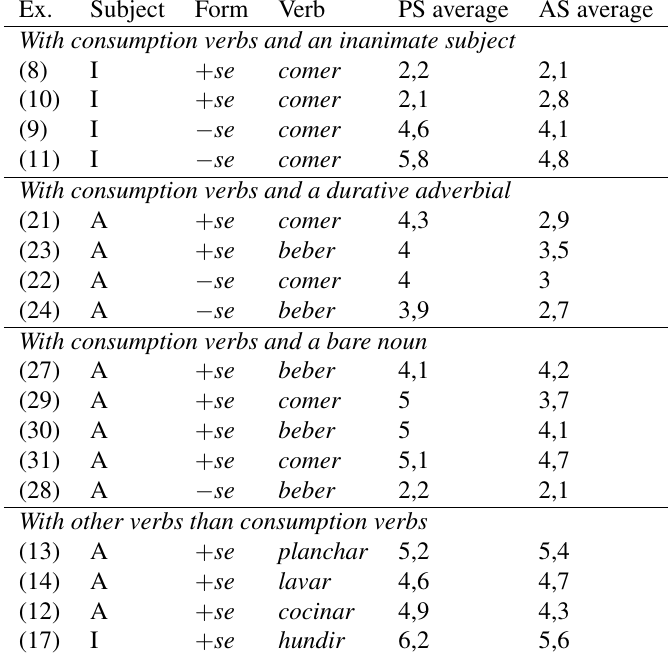
Table 2. Results of the survey (1 = completely acceptable, 7 = completely unacceptable)